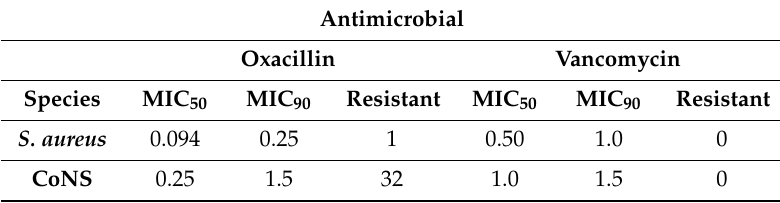
Table 2. Interpretation of susceptibility to oxacillin and vancomycin by the